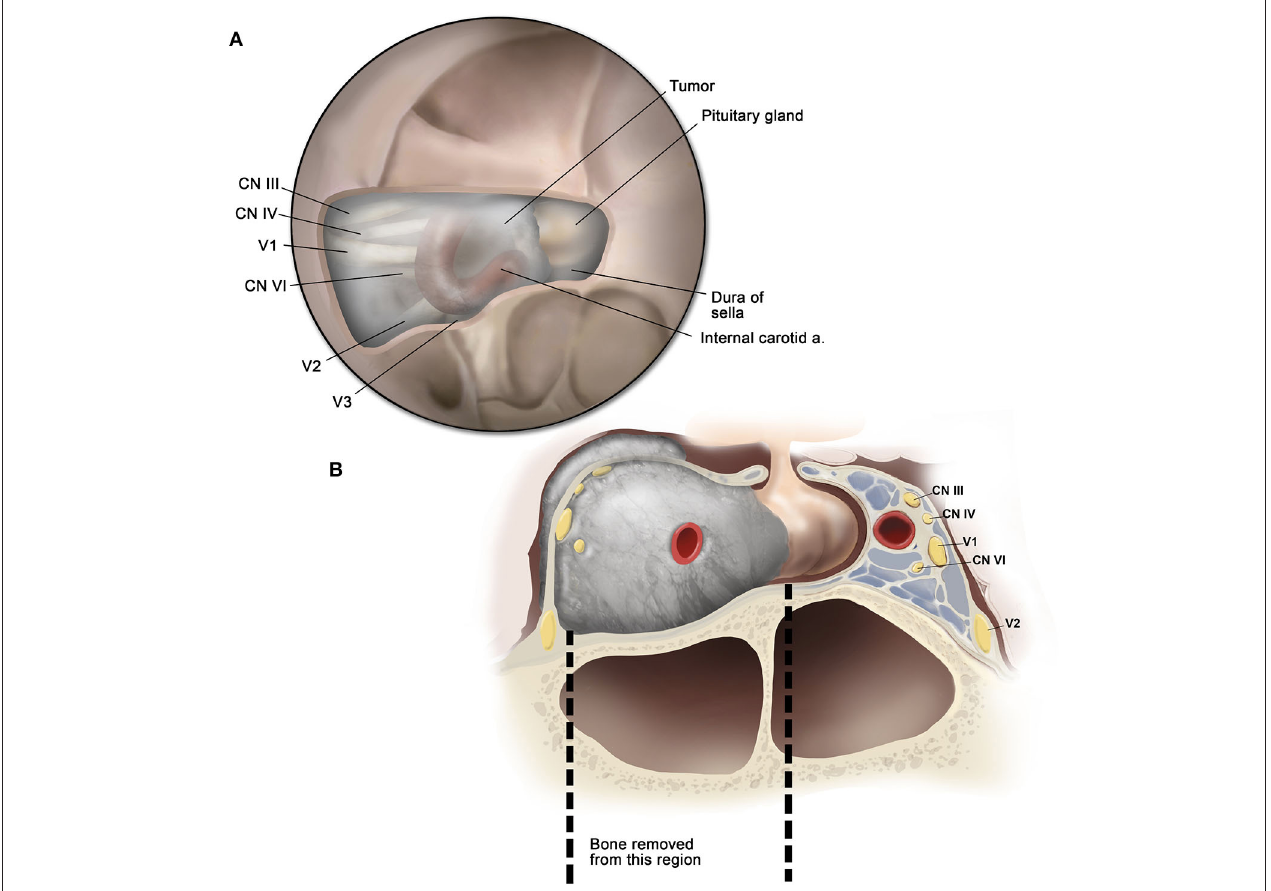
FIGURE 4 | Illustration of the surgical anatomy. (A) Endoscopic view showing the cavernous sinus anatomy after removal of the bone overlying the sella and cavernous sinus; (B) coronal cross-section illustration demonstrating the area of bone decompression.